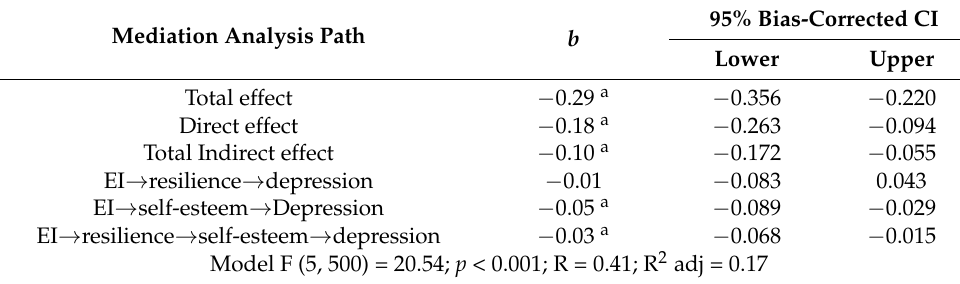
Table 2. Testing the pathways of the serial mediation